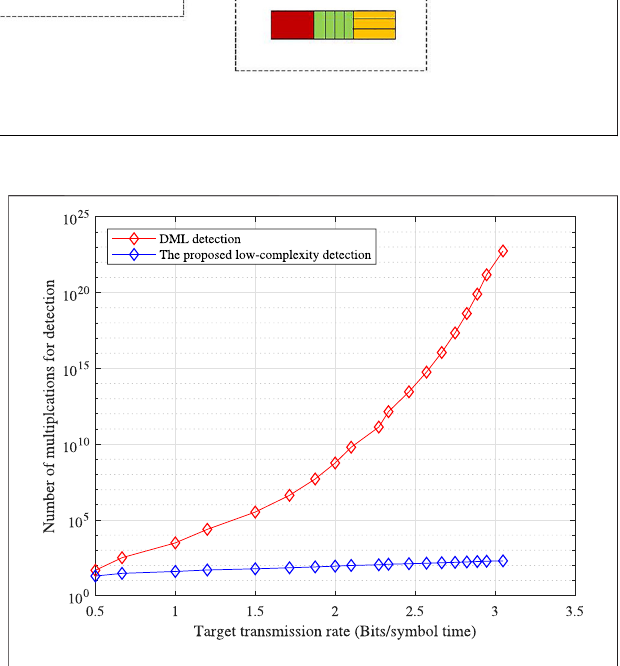
FIGURE 4 | Trend of the computational complexity for detection along with the increase in the target transmission rate.